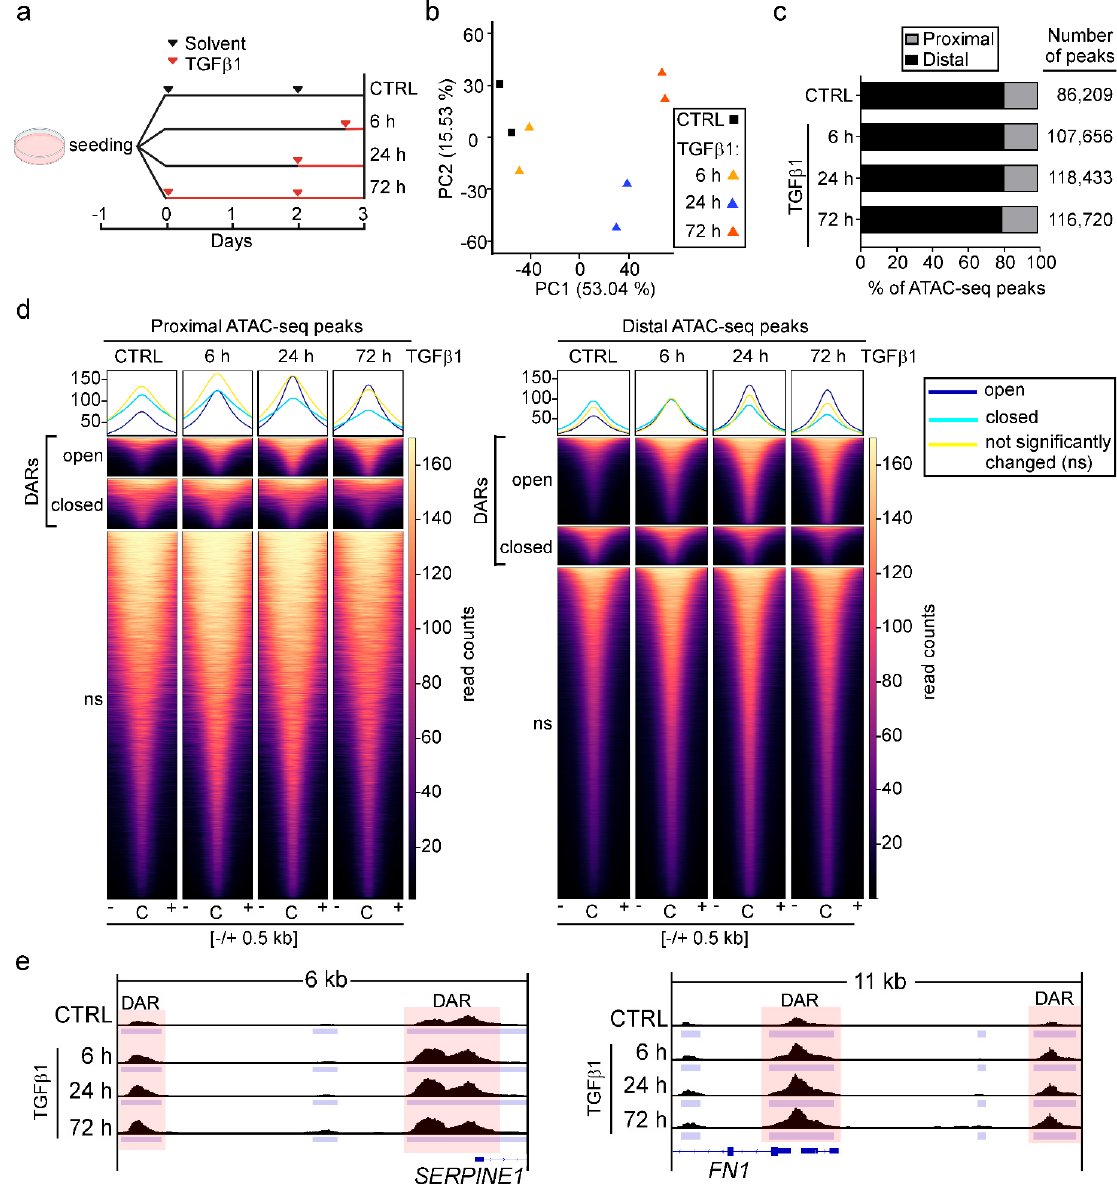
Figure 1. TGF β pathway activation predominantly increases chromatin accessibility at promoter- distal regions. ( a ) Experimental setup for the ATAC-seq time course experiment. MCF10A cells were seeded in four cell culture dishes and treated with 5 ng/mL TGF β 1 as indicated. A control (CTRL) plate received solvent solution for 72 h. All samples were harvested and subjected to ATAC-seq three days after seeding. ( b ) Principal component analysis (PCA) of ATAC-seq data from MCF10A cells treated with solvent or TGF β 1 as described in panel ( a ). For each condition, two independent biological replicates were analyzed. ( c ) Proportions of ATAC-seq peaks across experimental conditions annotated to proximal and distal genomic regions relative to the TSSs of annotated genes. ( d ) Read density heatmaps showing the distribution of ATAC-seq reads aligned to the centers (C) of proximal ( left ) and distal ( right ) peaks. Peaks that were significantly changing over the time course of TGF β 1 treatment compared to CTRL samples were classified as open or closed and denoted as differentially accessible regions (DARs). ( e ) Genome browser views depicting ATAC-seq tracks from CTRL and TGF- β 1-treated samples for SERPINE1 and FN1 . Peak locations are indicated by light blue bars. Peaks exhibiting statistically significant opening of chromatin are shaded in